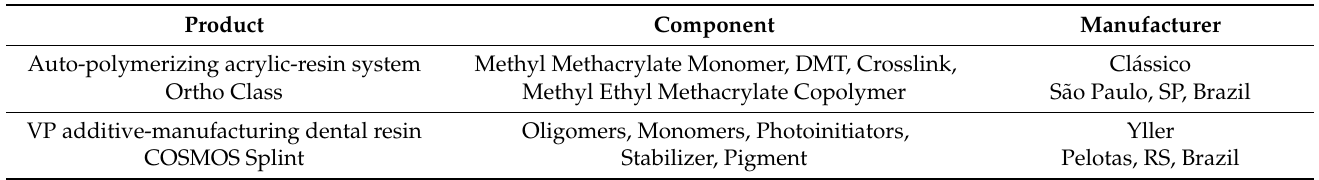
Figure 1. Specimen characteristics. ( A ): CG, auto-polymerizing acrylic resin; ( B ): EG-50, VP additive- manufacturing dental resin printed at 50 µ m resolution; ( C ): EG-100, VP additive-manufacturing dental resin printed at 100 µ m resolution. Table 1. Auto-polymerizing acrylic and VP additive-manufacturing resins used in the study.